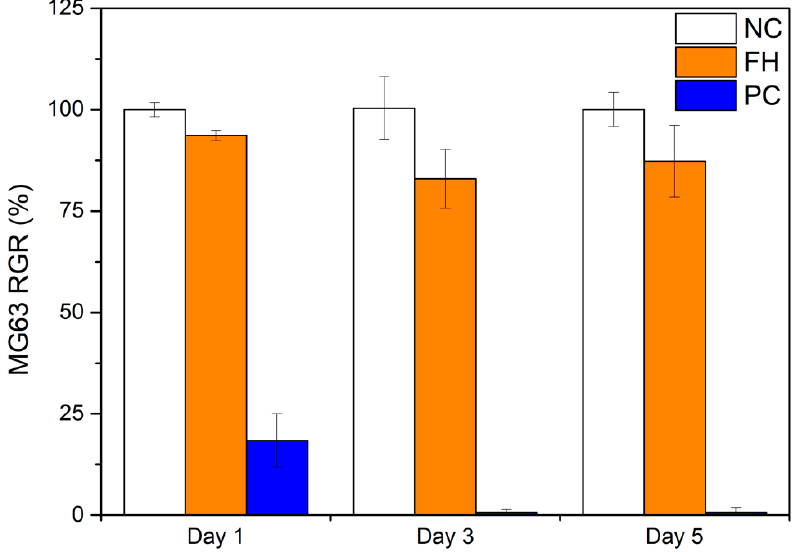
Figure 12. Relative growth rate of MG63 cells for 1, 3, and 5 days (FH, the extract; NC, negative control; PC, positive control).